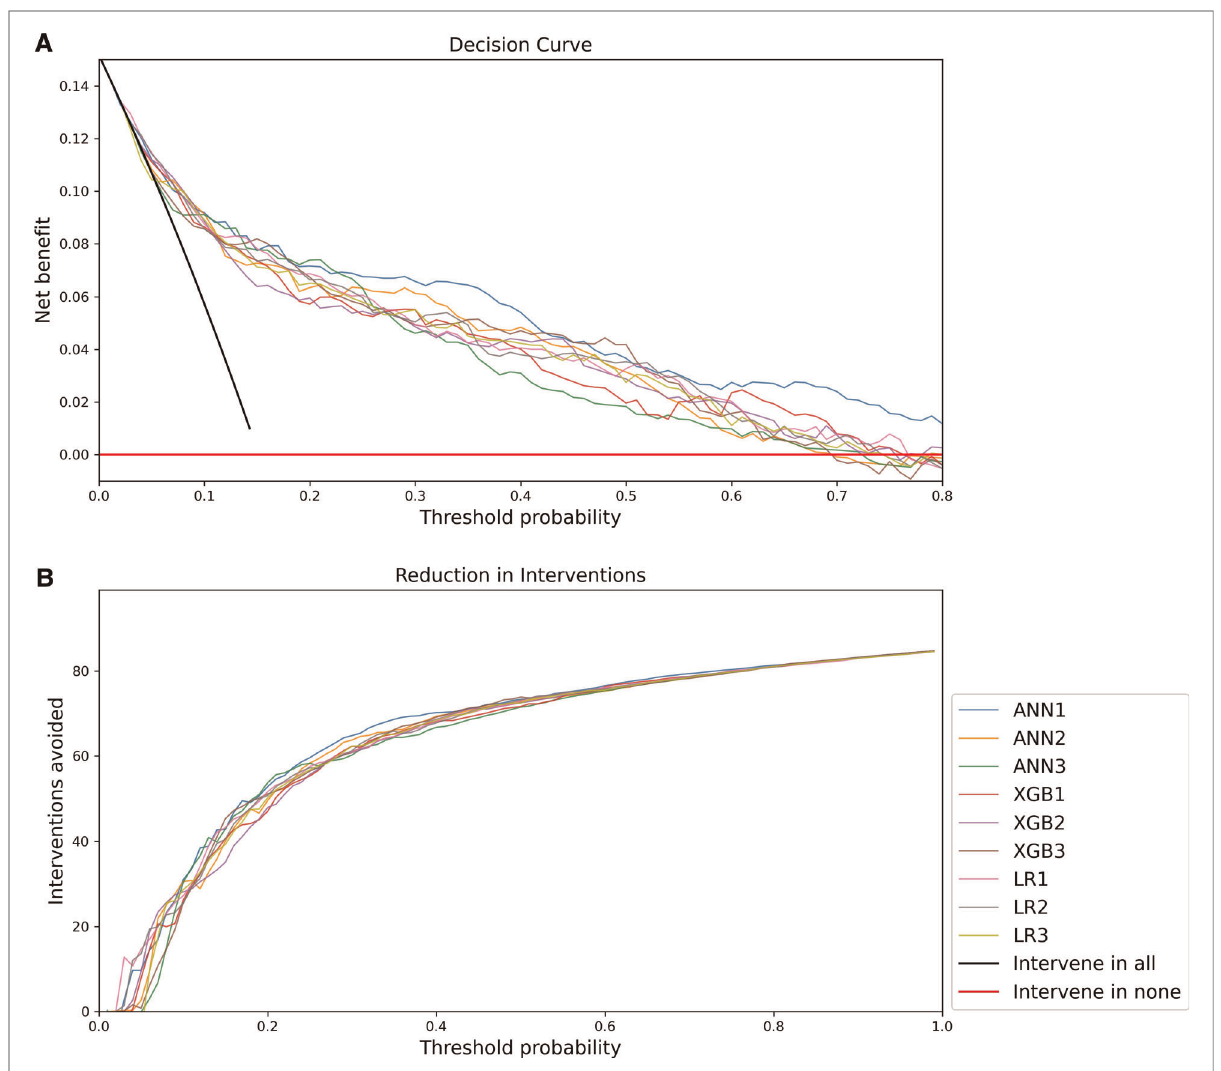
FIGURE 5 Decision Curve Analysis: ( A ) Net bene fi t compared to threshold probability; ( B ) Interventions avoided compared to threshold